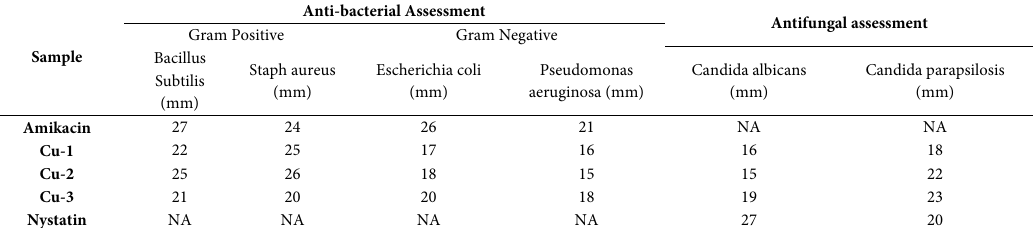
Table 3. Anti-bacterial and Anti-fungal assessment of Cu doped ZrO